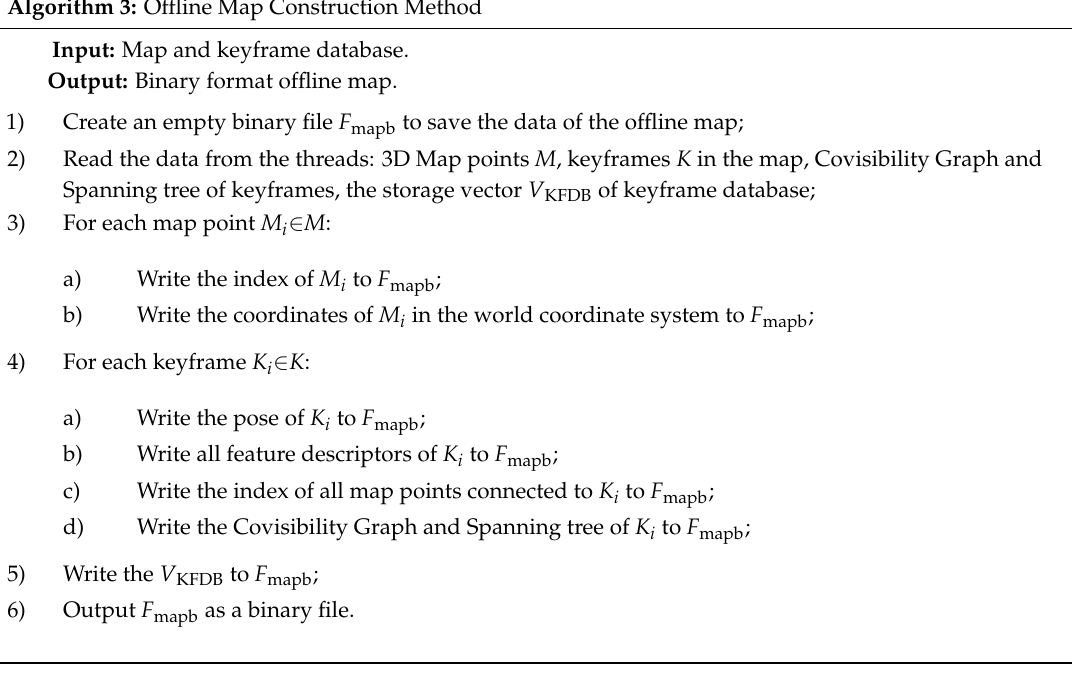
Algorithm 3: Offline Map Construction